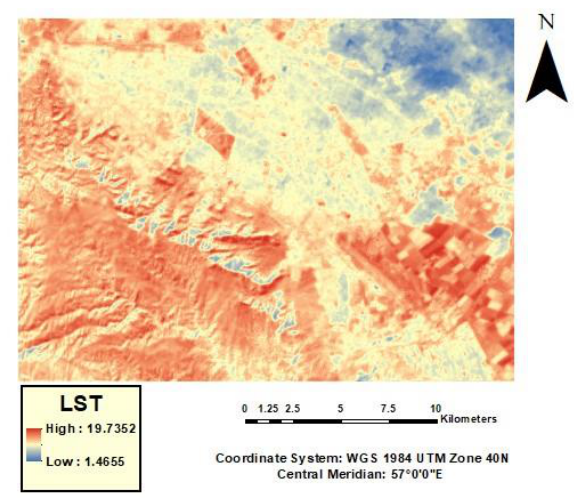
Figure 3. LST image calculated from Landsat-8 image